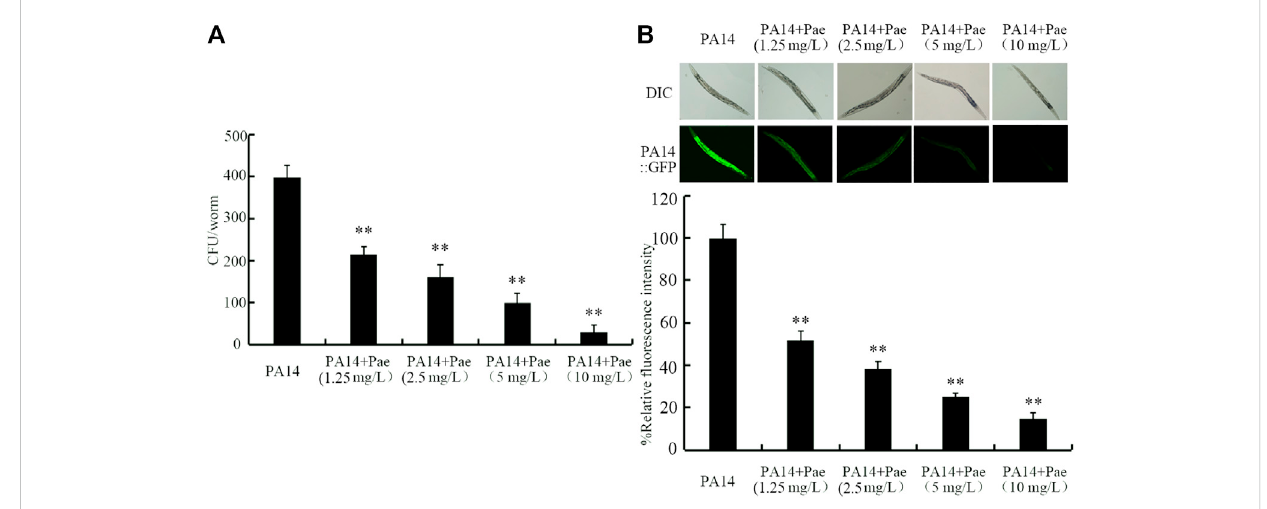
Effect of paeoni fl orin treatment on CFU of P. aeruginosa PA14 (A) and accumulatio of P. aeruginosa PA14:GFP (B) in nematodes after the infection. Pae, paeoni fl orin. ** p < 0.01 vs .